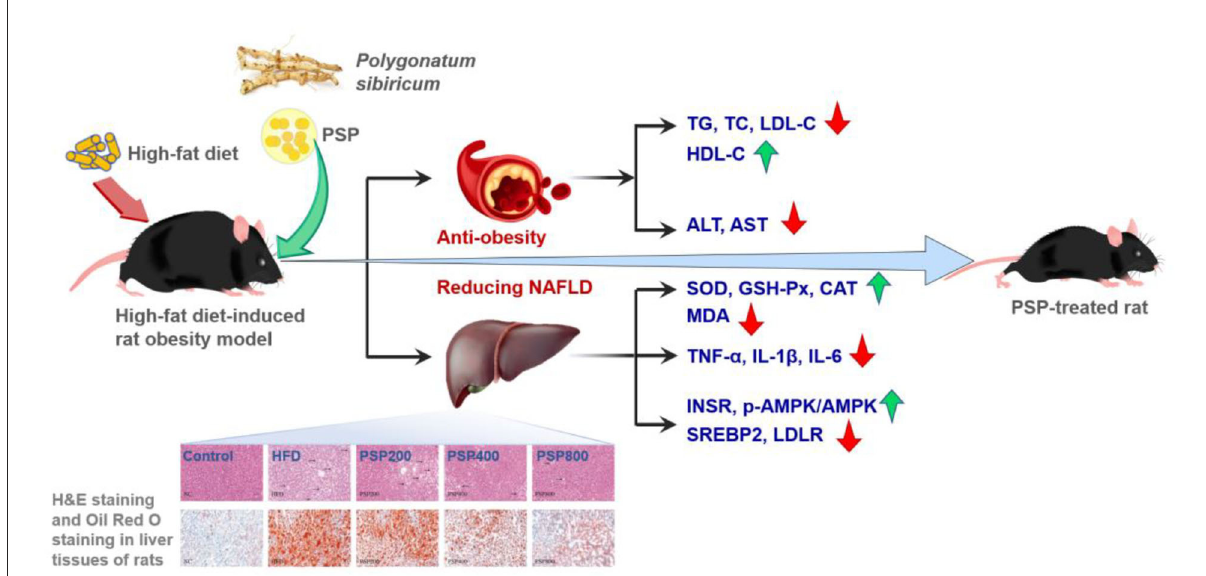
FIGURE6 Possible mechanism by which PSPs confer weight loss and alleviate non-alcoholic fatty liver disease (NAFLD) in rats with HFD-induced obesity (18). Copyright 2022, Elsevier.